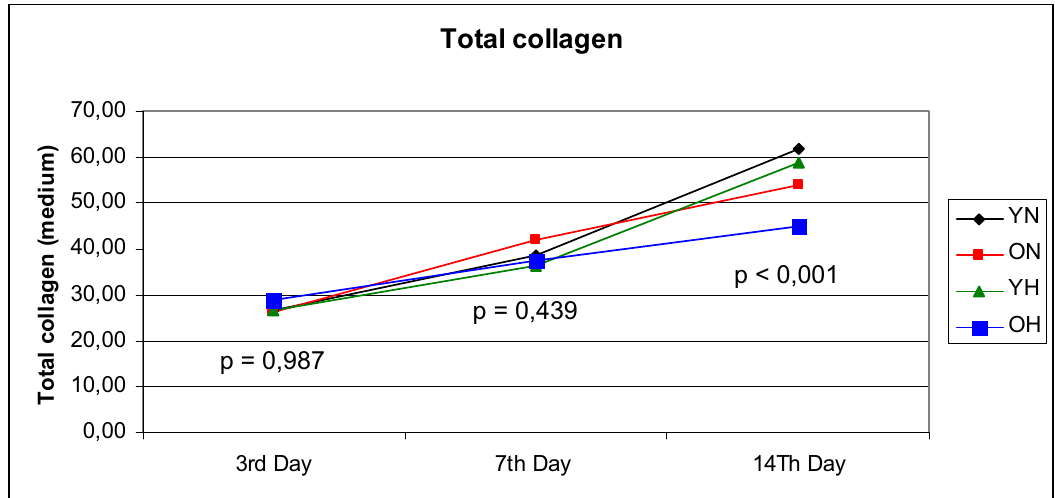
FIGURE 3 – Collagen gain in the four groups at the three